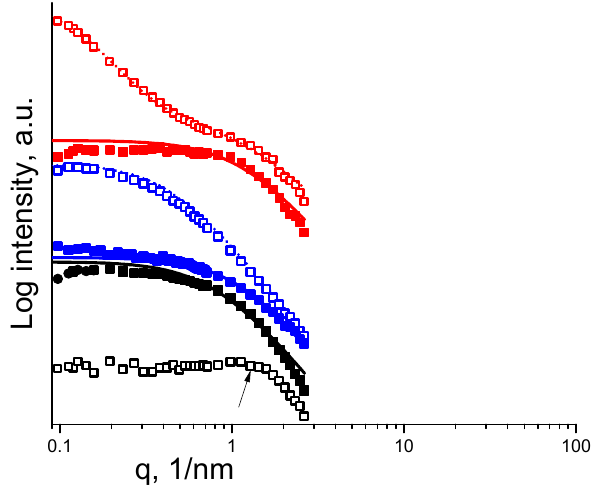
Figure 5. SAXS measurements of PAH, PAA and PECs in water or water/ethanol. PAA and PEC curves are shifted for clarity; black—PAH; blue—PAA; red—PEC; open squares—dissolved in water; full squares—dissolved in water/ethanol. Fitting of the data was performed using Equation 1 or 2. The slopes at a high q, were estimated by linear equation. The black arrow marks a broad peak of PAH in water. Table 2. Estimated value of the correlation length according to the solution scattering functions. (Equation 1 or 2).